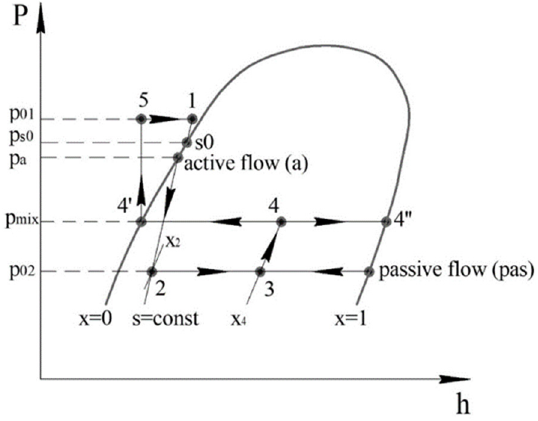
Figure 1. The design scheme of the operating processes in the vortex-type LSJA.